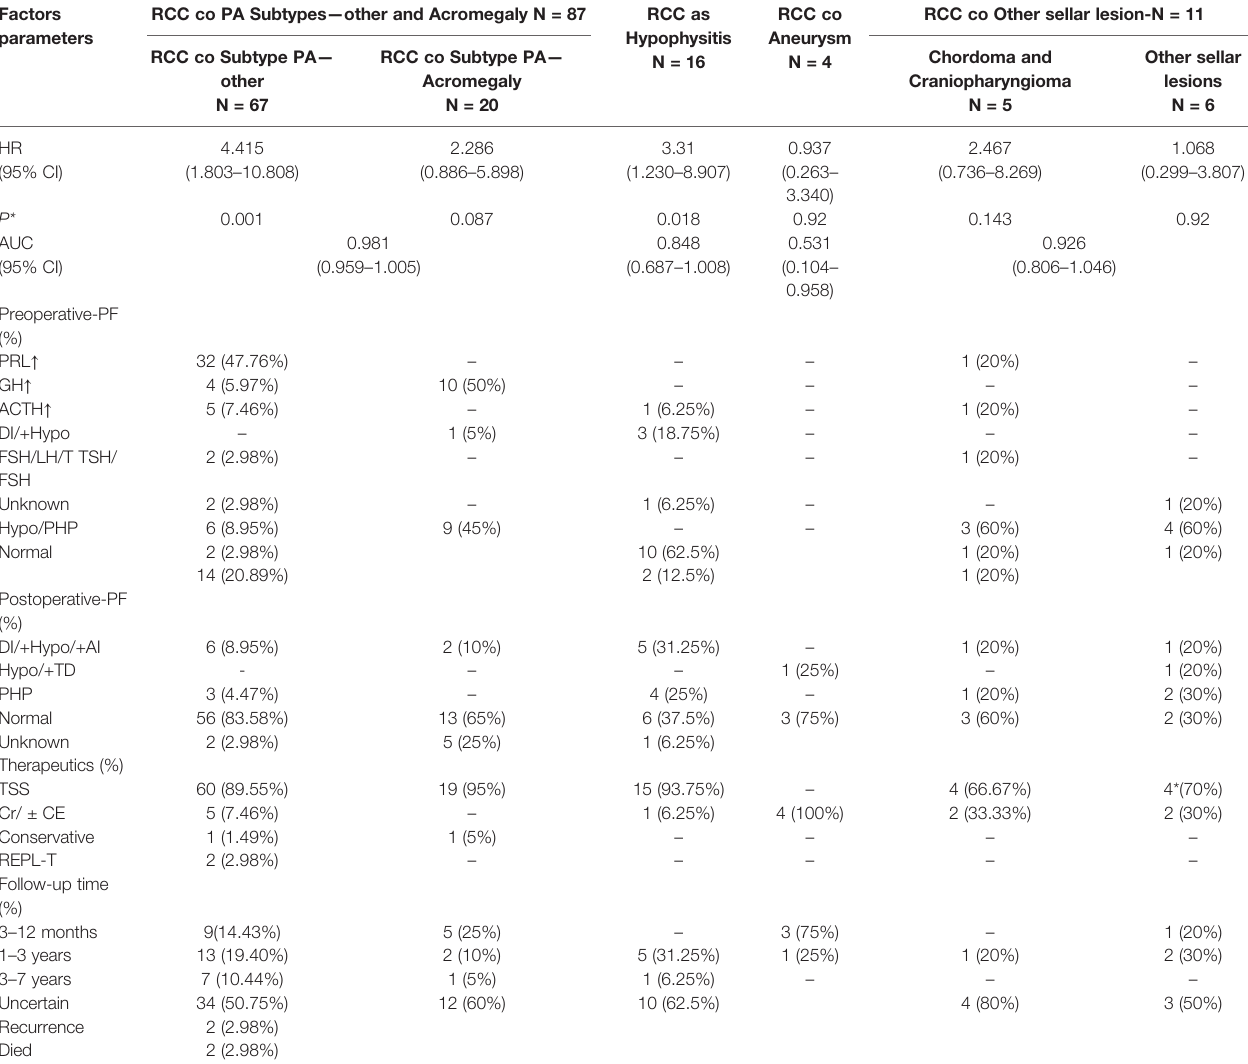
TABLE 4 | Total surgical data and follow-up sellar lesion and pituitary adenoma subtype. Factors